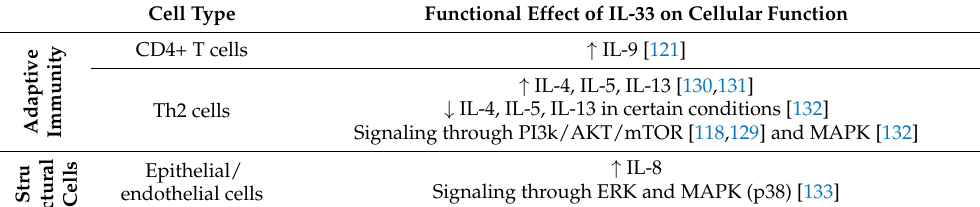
Table 2. Cont. Cell Type Functional Effect of IL-33 on Cellular